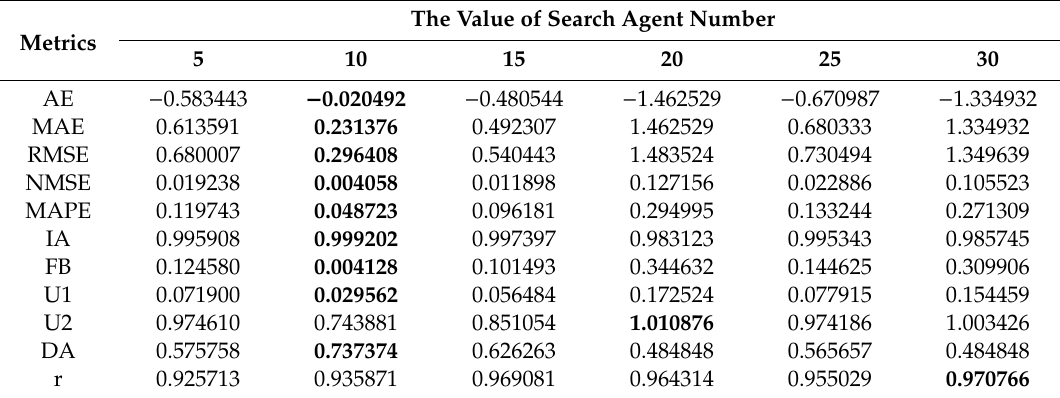
Table 14. Sensitivity analysis of di ff erent search agent numbers based on MOGWO.